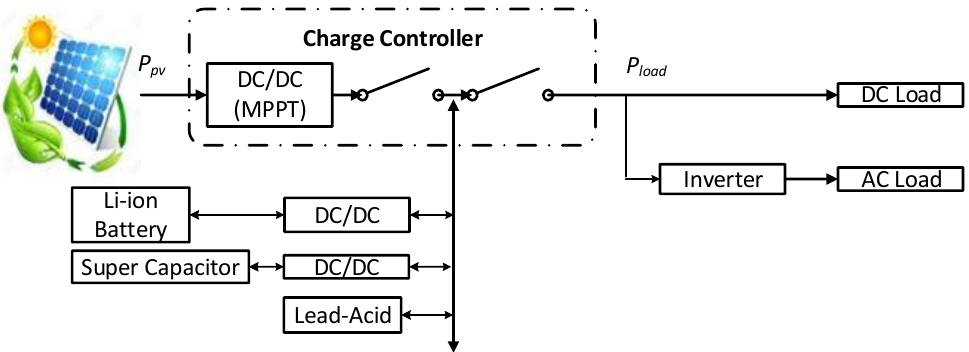
Figure 14. Autonomous PV grid system with three-level HESS.